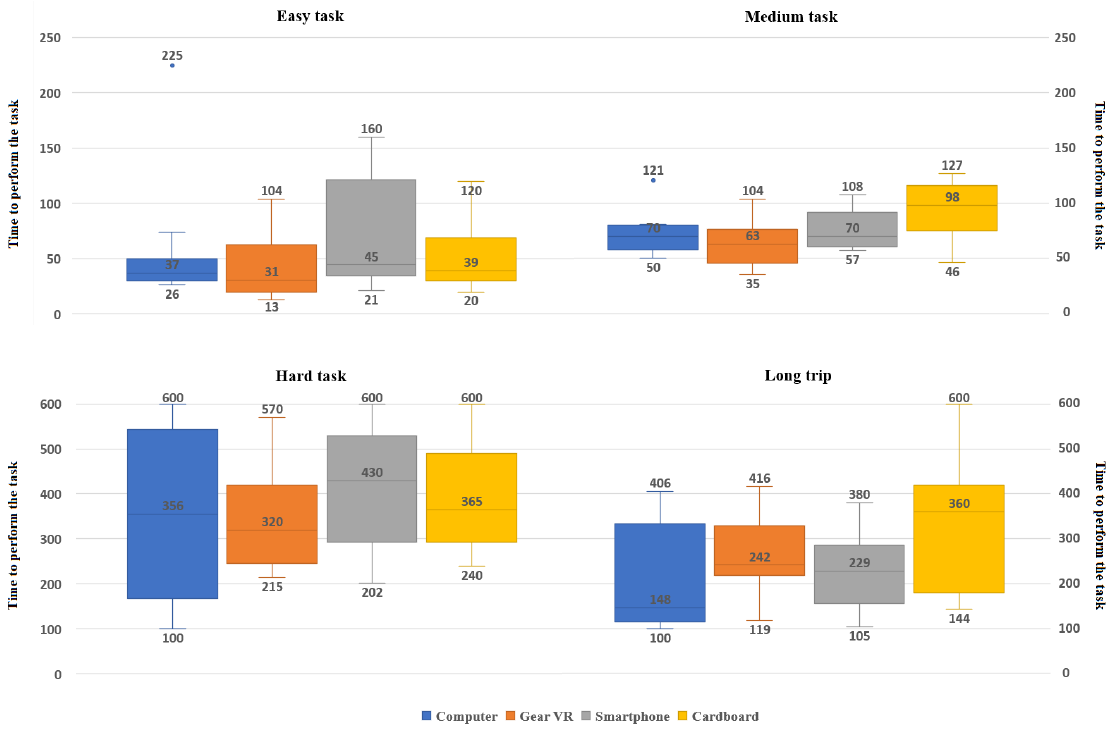
Figure 7. Box plot of time data per task (in seconds).